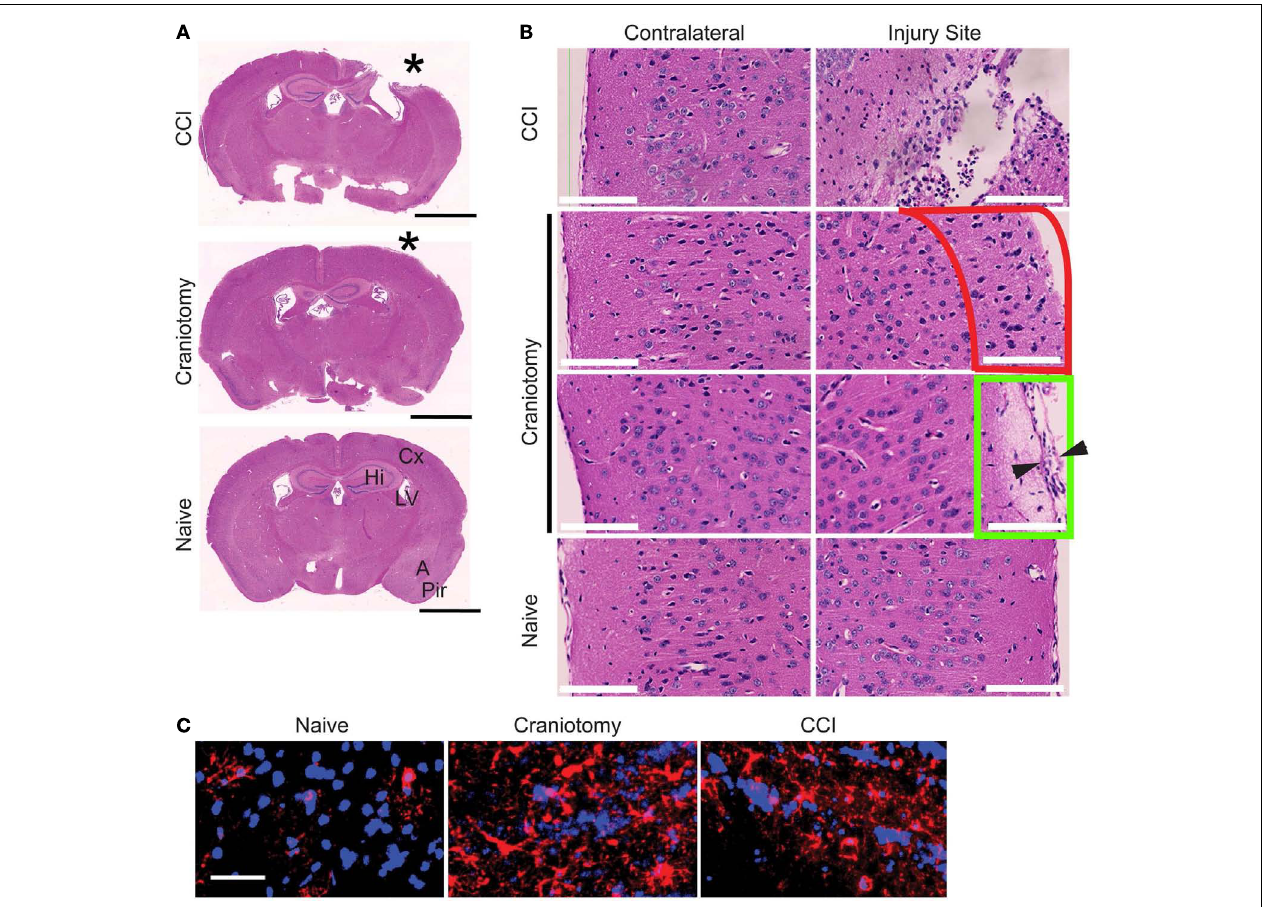
indicated. Red outline indicates cortical layer 1, and Green outline indicates region of altered dura (arrowheads) and underlying tissue at the injury site of the craniotomy samples. Bar, 100 µ m. (C) Anti-GFAP immunofluorescence microscopy analysis of frozen brain sections from CCI, craniotomy, and naïve animals. Regions imaged were proximal to the injury site. CCI and craniotomy brains were harvested at day + 3. Data are representative of three mice from each experimental group (naïve, craniotomy, and CCI). Bar, 40 µ